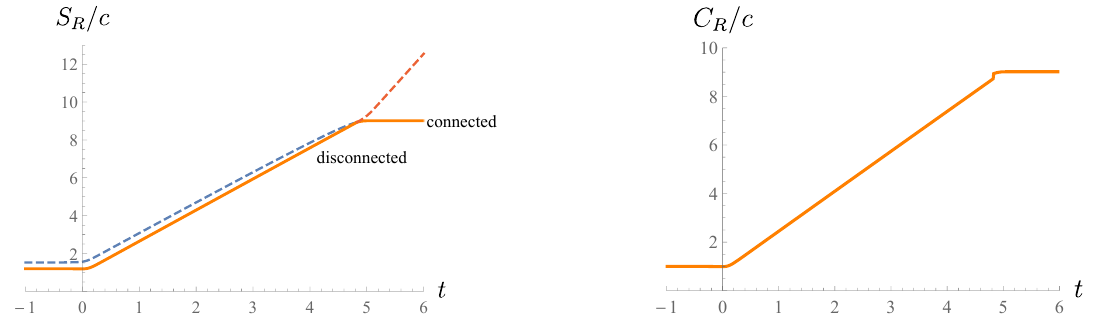
Figure 8 . The entropy [Left] and capacity [Right] in the moving mirror model whose trajectory mimics an eternal black hole with radiation. We set the subsystem to be an interval R = [ z ( t ) + 0 . 1 , z ( t ) + 10] with β = 0 . 1 , (cid:15) = 0 . 1 and S bdy /c = 0 . 1 . The phase transition from the disconnected channel to connected one occurs around t phase = 5 . The capacity shows a discontinuity by 2 S bdy = 0 . 2 c at that